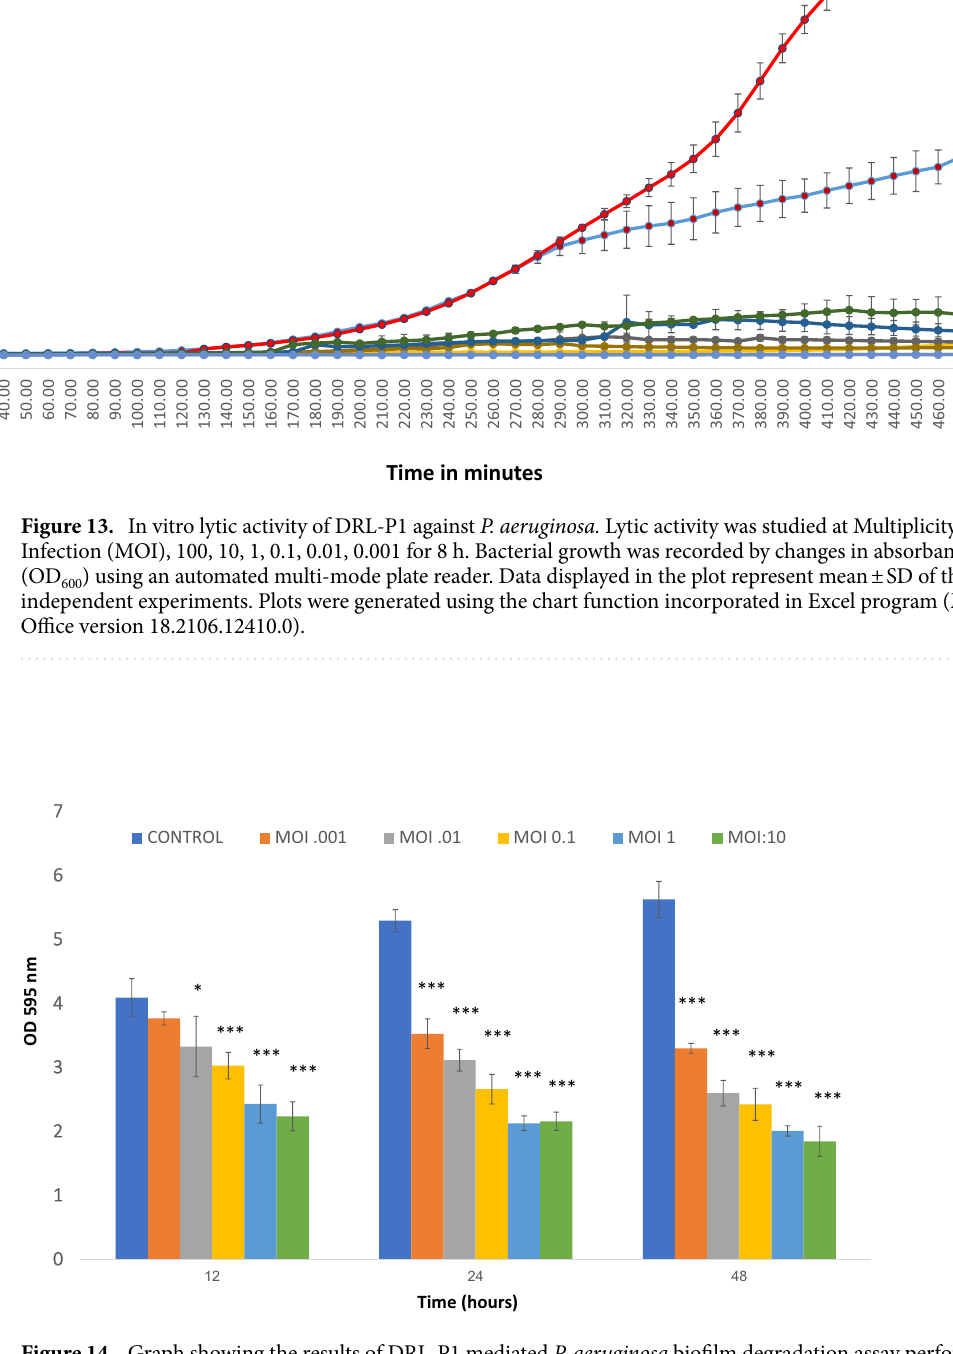
Figure 14. Graph showing the results of DRL-P1 mediated P. aeruginosa biofilm degradation assay performed at various MOIs (10, 1, 0.1, 0.01, 0.001). Non-phage treated biofilm was used as a positive control. OD at 595 nm was measured at 12, 24 and 48 h. Data represents mean ± SD from the triplicate experiments. *** P < 0.001 or * P < 0.05 indicate significant difference between the control and the respective phage treated samples after a particular period of time. Plots were generated using the chart function incorporated in Excel program (MS Office version 18.2106.12410.0) and statistical analysis were performed using the GraphPad PRISM computer program (Trial version 7.05; https:// www. graph pad. com/ scien tific- softw are/